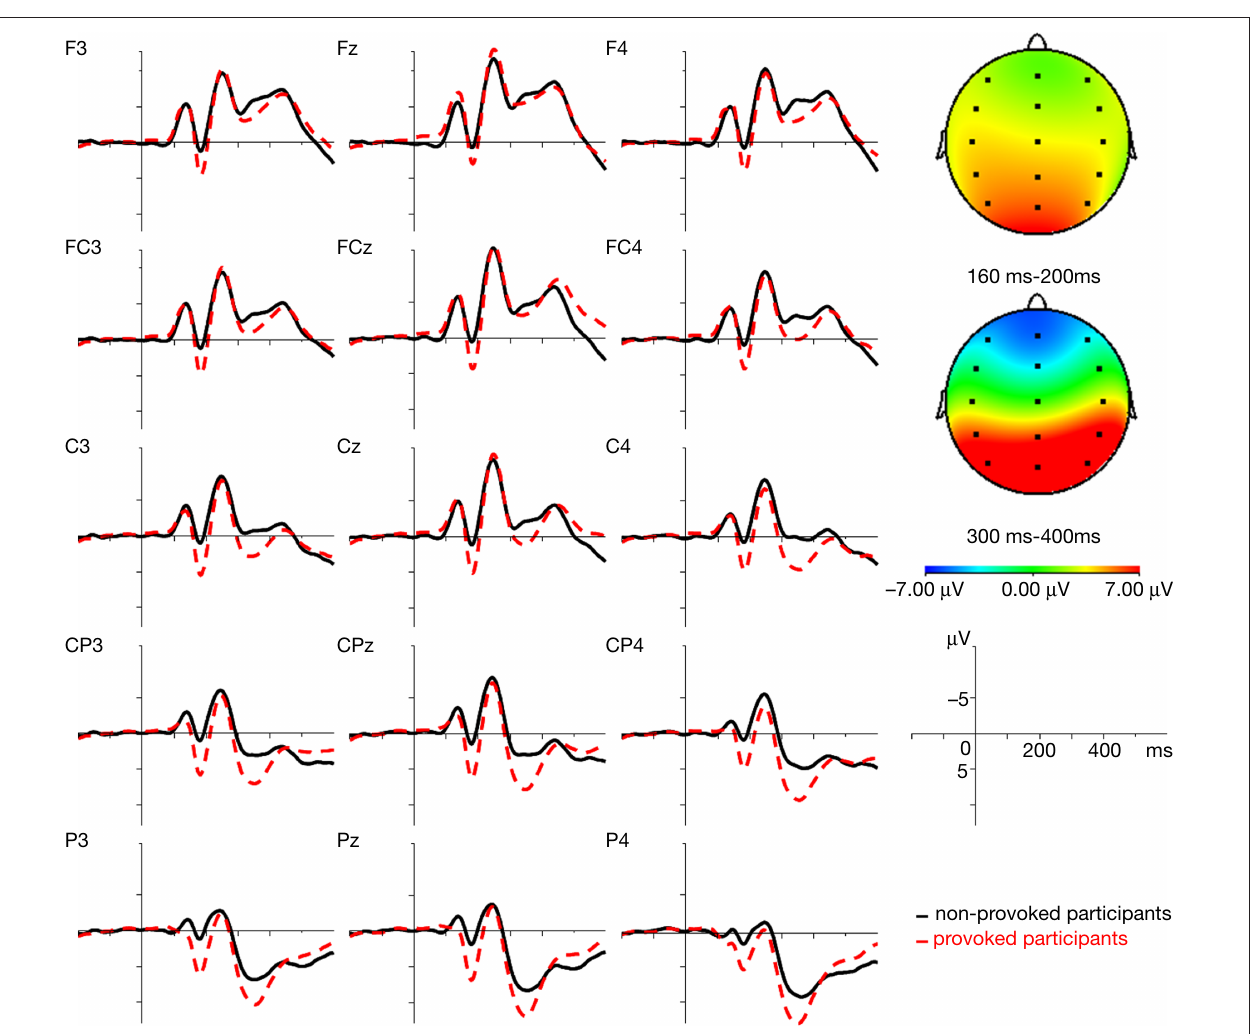
of the P2 (160–200 ms) and P3 (300–400 ms). Note: in the difference maps, red indicates a greater positivity in the provoked than in the non-provoked group and blue refers to a greater positivity in the non-provoked compared to the provoked group.